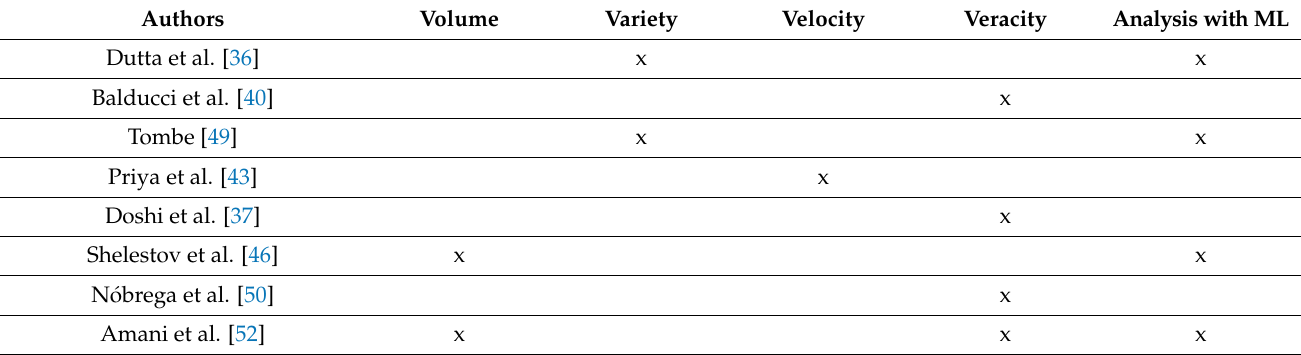
Table 4. Challenges in agricultural Big Data and